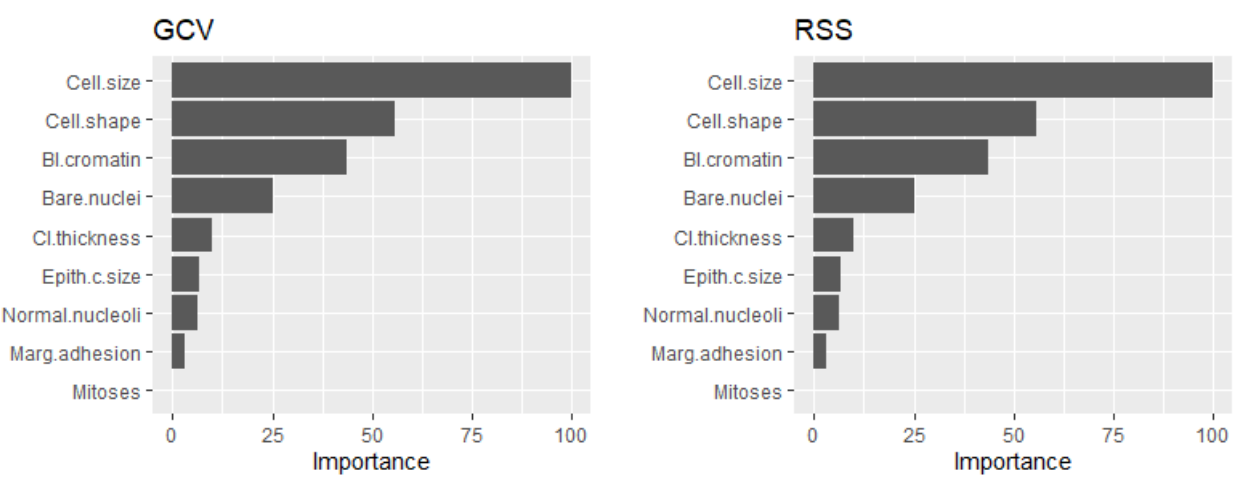
Figure 23. GBM important variables for the breast cancer data.